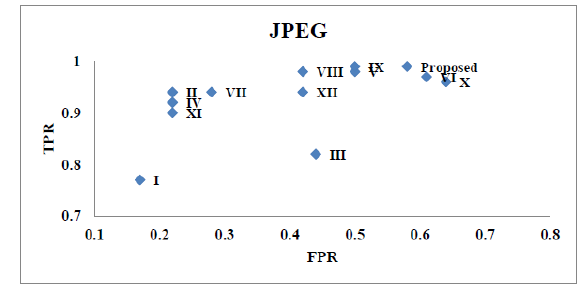
Figure 9. TPR vs. FPR: JPEG.